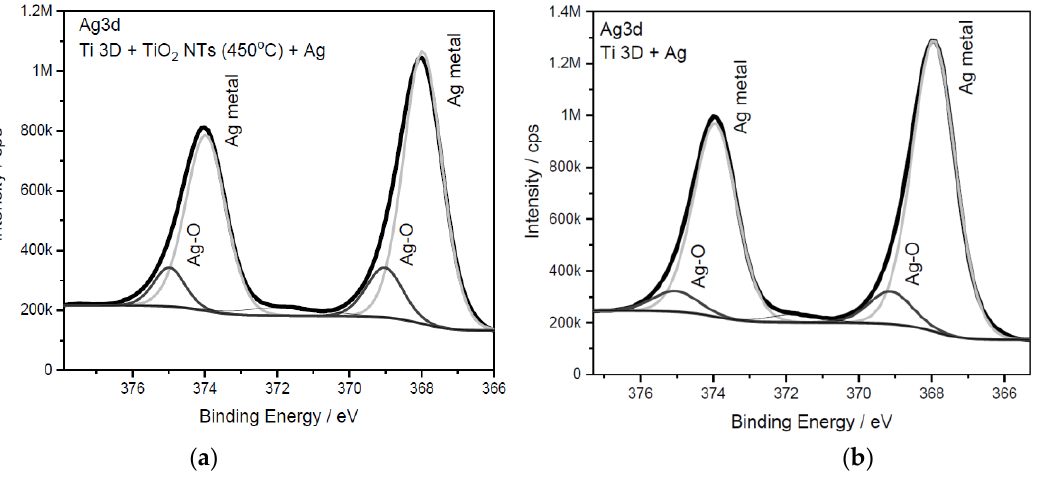
Figure 8. ( a ) XPS high-resolution spectra of silver Ag3d for Ti 3D substrate ( b ) after anodic oxidation process and annealing at 450 °C. process and annealing at 450 ◦